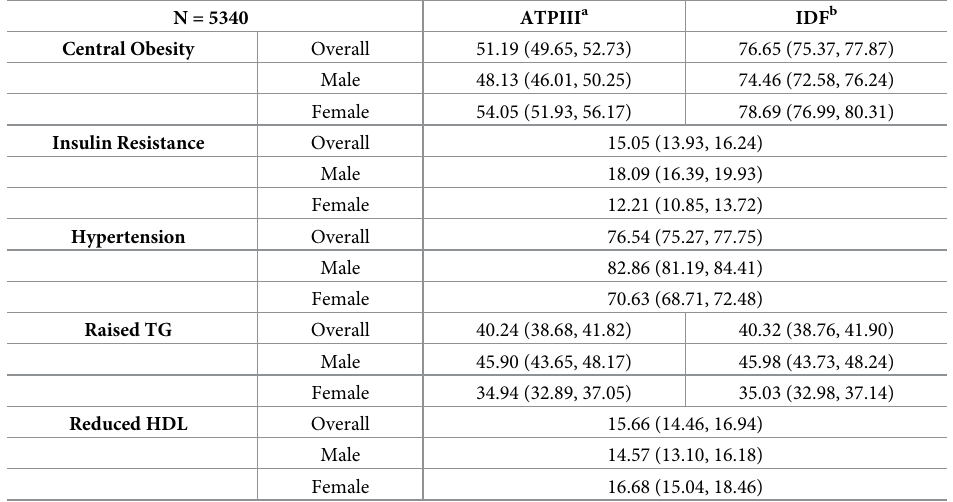
Note: Data presented as weighted proportions with percentages with 95% confidence intervals in brackets. Metabolic syndrome (MetS) as per International Diabetes Foundation (IDF) and National Cholesterol Education Program Third Adult Treatment Panel (ATPIII) criteria a